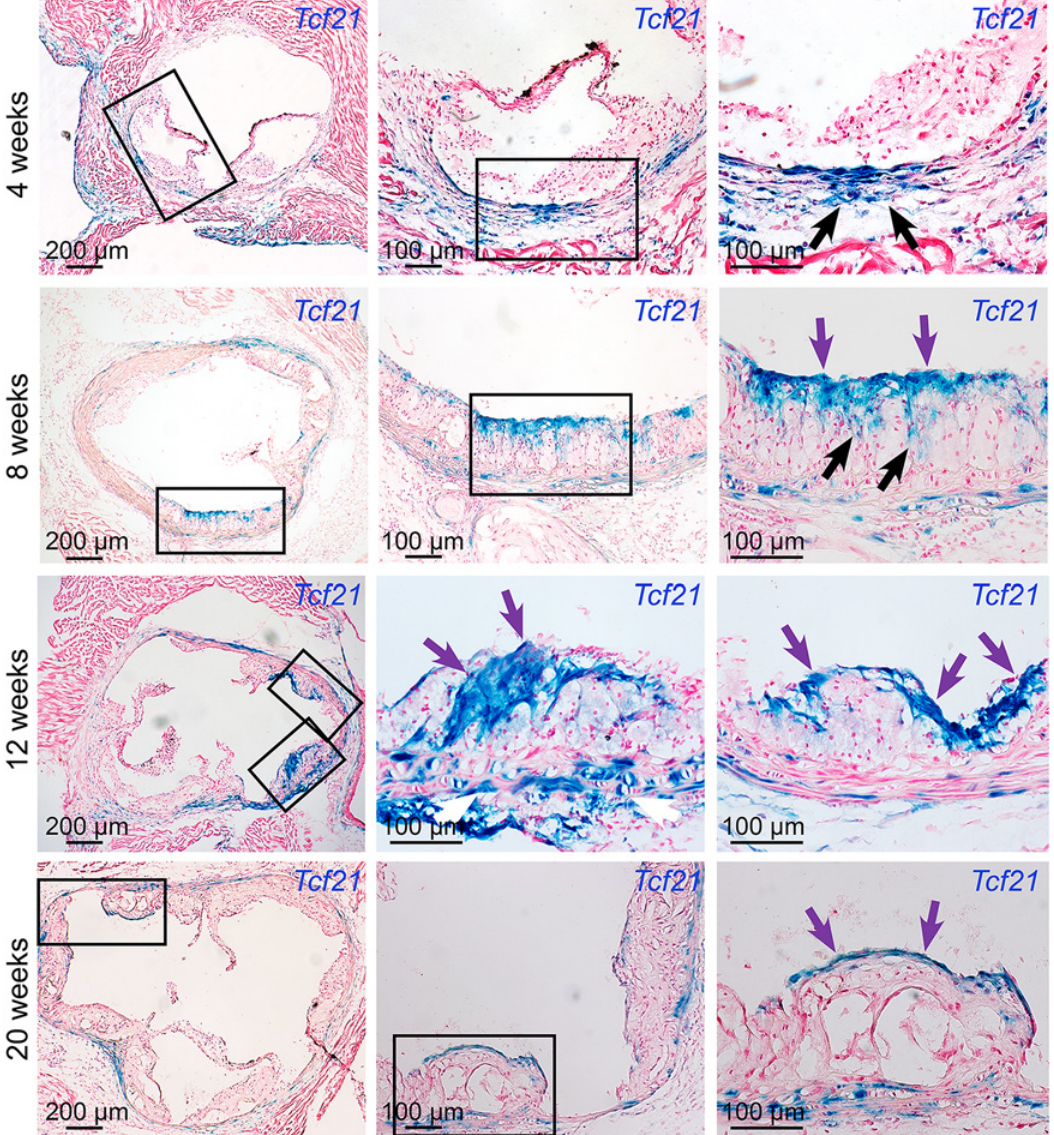
Fig 3. Tcf21 expressing cells are found in atherosclerotic lesions. Tcf21 lacZ/+ , ApoE -/- mice were fed HFD from 4 weeks of age for 4, 8, 12, or 20 weeks, proximal aortic tissues were harvested, and Tcf21 gene expression evaluated by Xgal staining to visualize β -galactosidase activity, and sections were counterstained with nuclear fast red to visualize disease lesion architecture. For each timepoint, boxes in low-power images at left indicate regions examined at high power in panels to the right. At 4 weeks of HFD there was no expression in the lesions although clusters of lacZ expressing cells identified in the media in regions below the disease lesions (arrows). At the 8-week timepoint cells with β -galactosidase activity were seen extending from the media to the luminal surface of the lesion (black arrows) in the vicinity of the forming fibrous cap (purple arrows). By 12 weeks of HFD there was extensive labeling of cells in lesions, with the appearance of β -galactosidase positive cells in the vicinity of the fibrous cap (purple arrows). Also, there was extensive staining of cells in areas of disrupted medial structure (white arrows). After 20 weeks of HFD, Tcf21 -expressing cells had decreased in the lesions but formed a narrow band of cells associated with the fibrous cap (purple